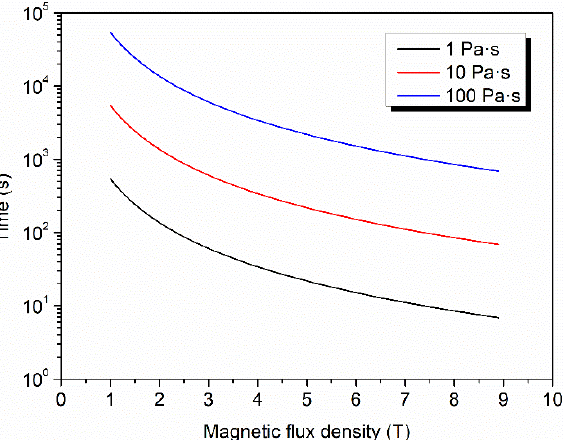
Figure 4. The effect of viscosity on alignment time as a function of magnetic flux density.